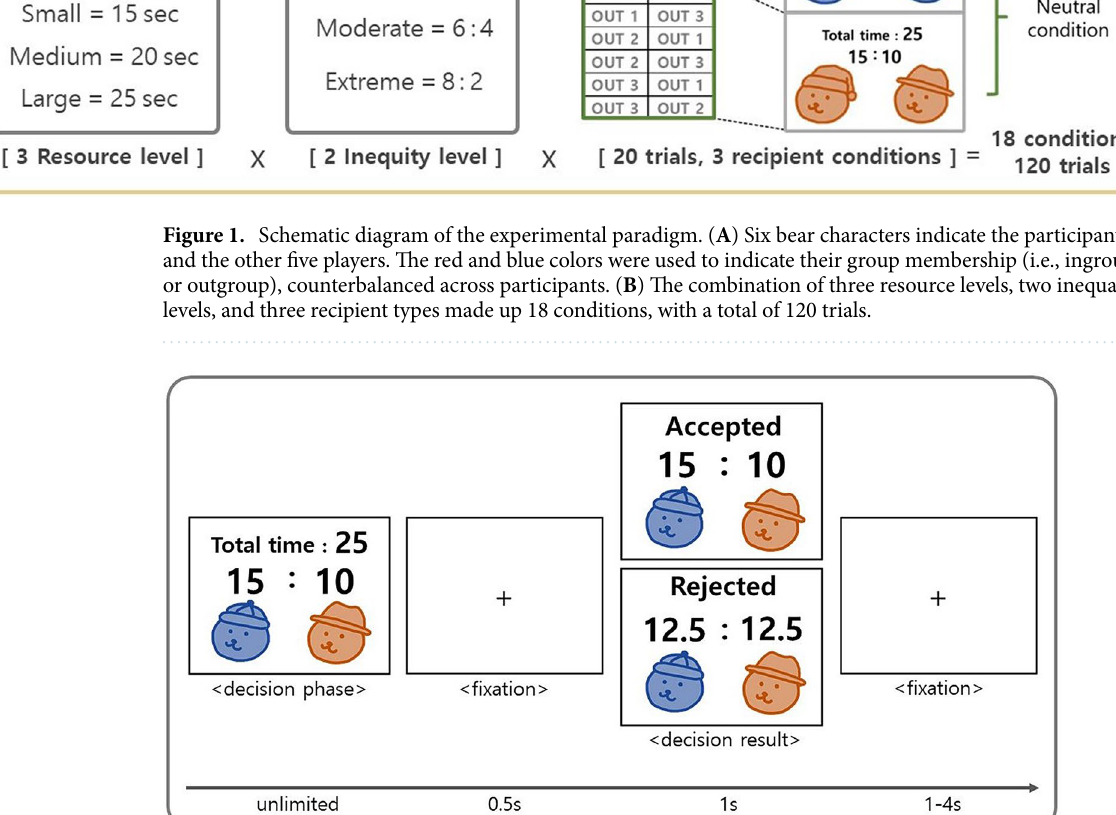
(Fig. 2). Participants were told that the distributed time was then used as the time limit for the recipients to